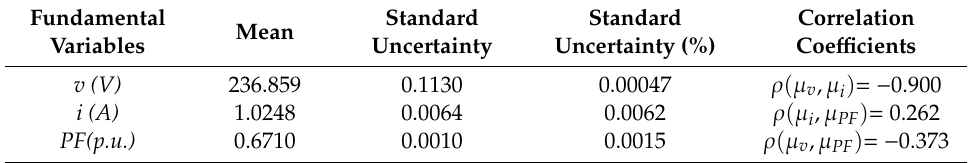
Table 15. Fundamental variables and standard